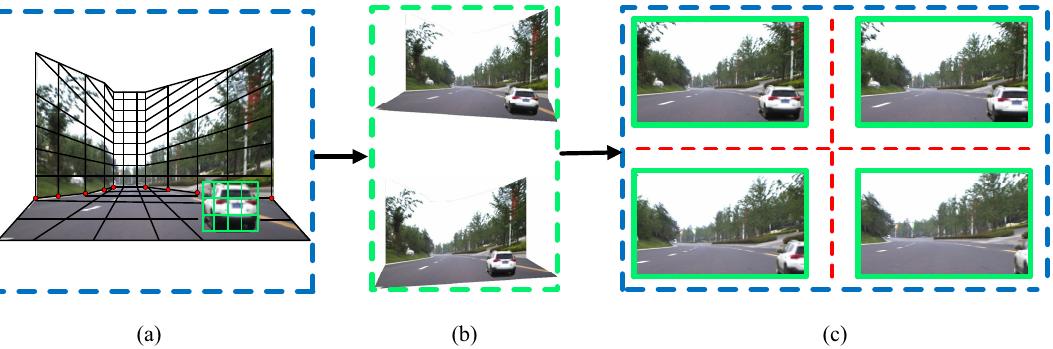
Figure 7. New viewpoint images rendering. ( a ) the 3D traffic scene model. The black mesh denotes the background scene, while the green mesh denotes the foreground vehicle; ( b ) the control of view angles; ( c ) the new viewpoint images.